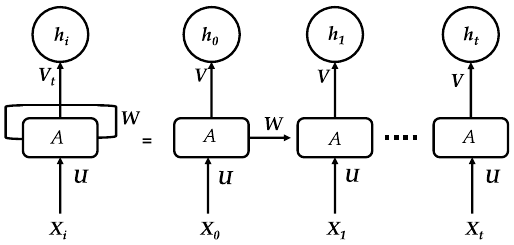
Figure 3. Architecture of an RNN network.